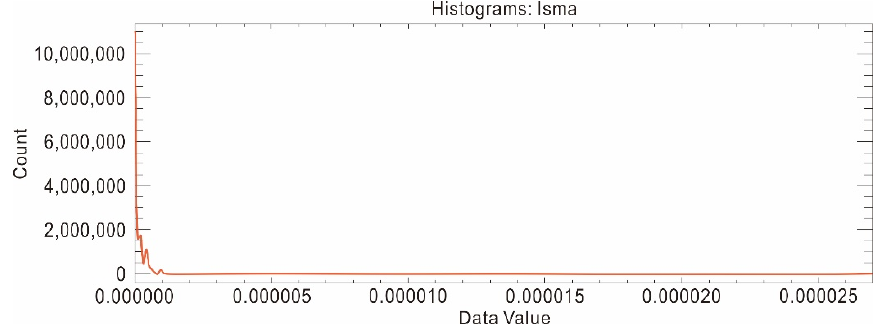
Figure 8. RMSE spatial distribution of the linear spectral decomposition.